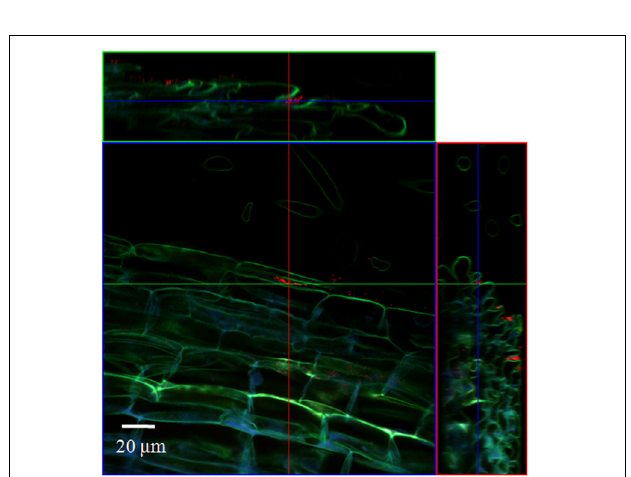
FIGURE 3 | CLSM images of corn salad root tips. The plant seedlings were inoculated for 1h with S. enterica sv. Weltevreden at an inoculation density of 4 × 10 6 CFU/ml. The plants were harvested after 3 weeks of growth in an